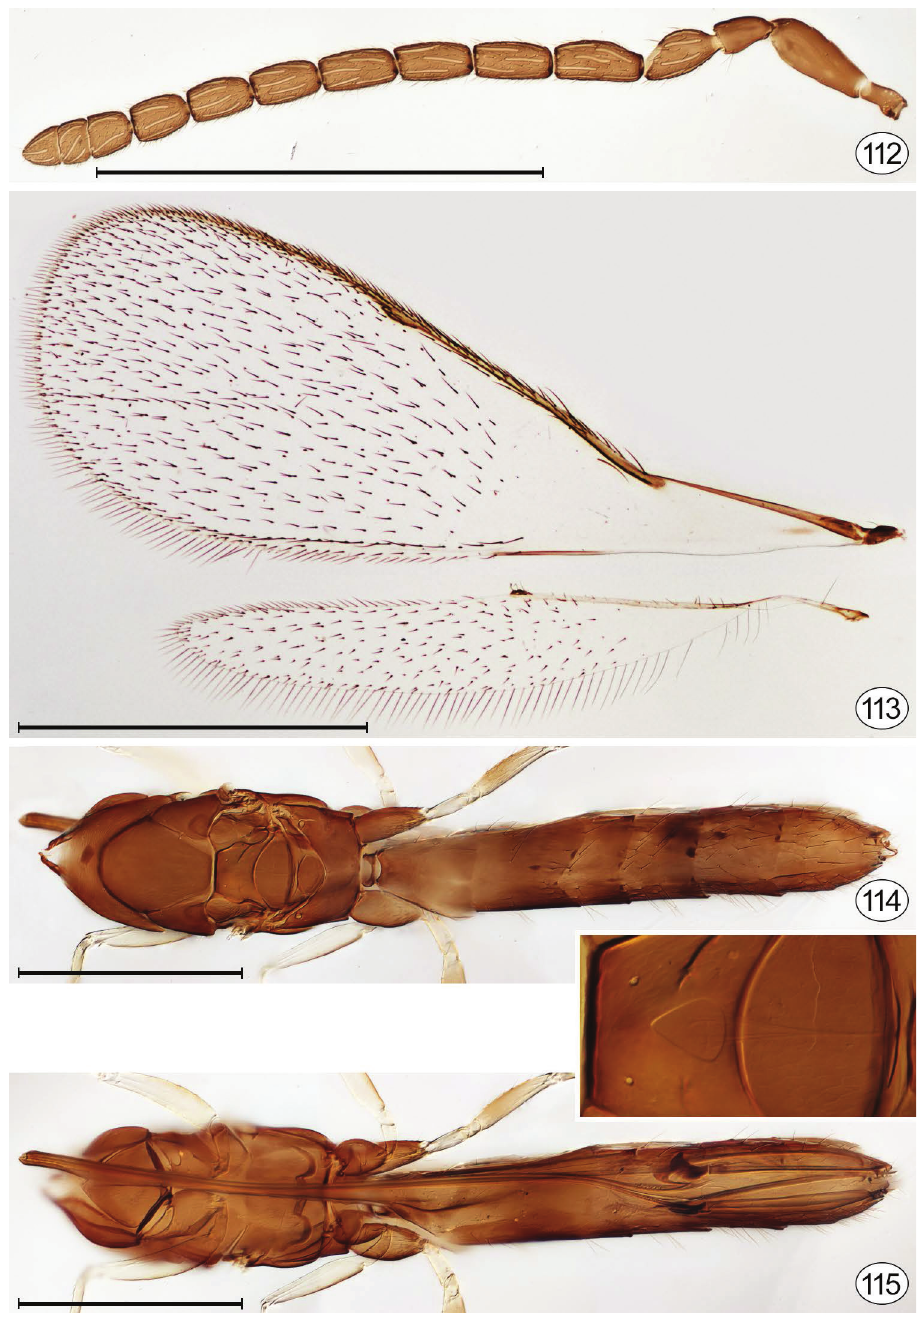
Figures 112–115. Neotriadomerus longiovipositor , holotype. 112 antenna 113 wings 114 mesosoma + metasoma, dorsal (inset shows fenestra of scutellum) 115 mesosoma + metasoma, ventral as seen dorsally through body. Scale bar = 500